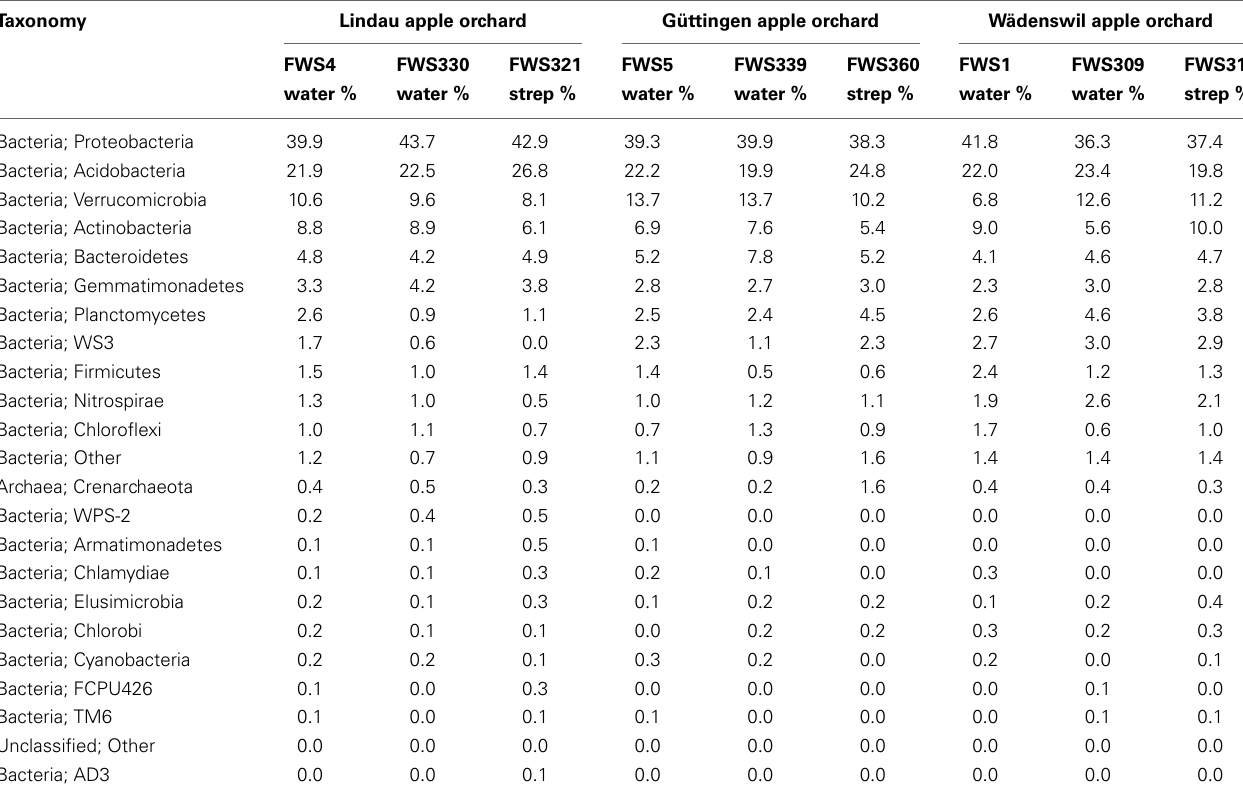
Table 3 | Taxonomy and percentage of the bacterial phyla population abundances of the bacterial 16S rRNA gene sequences from orchard soils treated with streptomycin in comparison to those treated with water in descending order of percentage of the population. Taxonomy